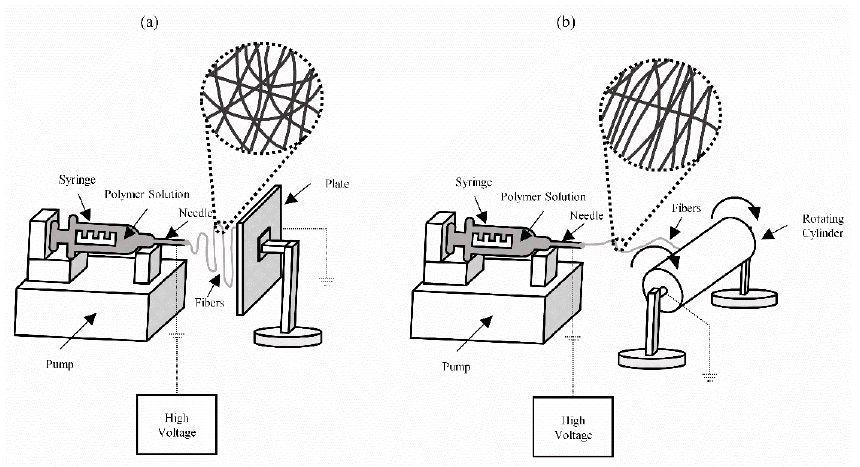
Figure 4. Electrospinning setups and collector types: ( a ) flat plate; ( b ) drum collectors.